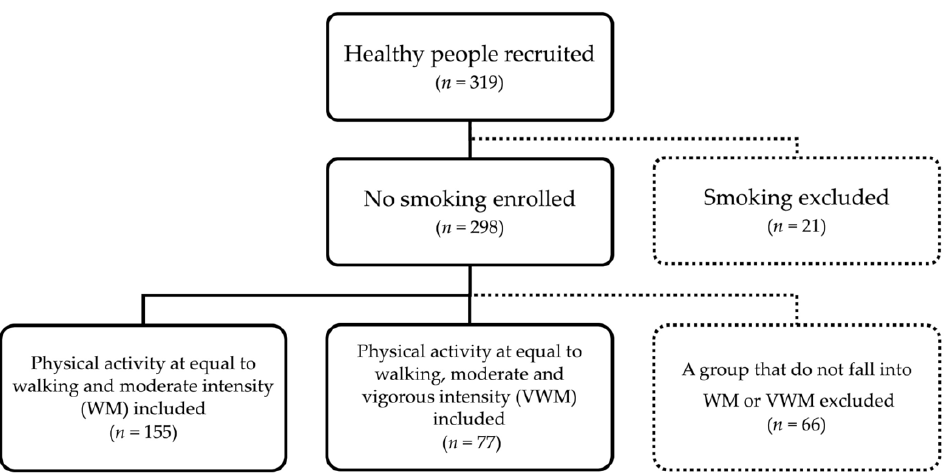
Figure 1. Inclusion/exclusion criteria for the participants. Two-hundred ninety-eight people without smoking habits were extracted. Among them, we analyzed 232 healthy men and women after excluding 66 participants who were not categorized in a group performing all physical activities (including walking, moderate physical activity, and vigorous-intensity physical activity) or a group performing some physical activities (including walking and moderate-intensity physical activity). The µ ’ s in the supraclavicular region was found to be 8.3 (7.3, 9.4) (medians (the first quartile, the